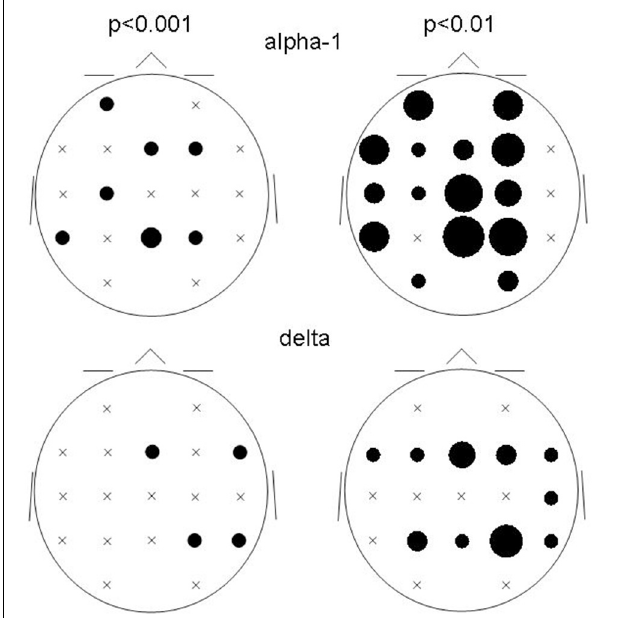
FIGURE 3 | Bubble sizes indicate how many connectivities anchored at each ROI in the comparison between patients and controls. Head seen from above. Semi schematic array of the 19 ROIs; crosses indicate ROIs where no connectivity anchored. Results for the alpha-1 and delta frequency bands are shown for the two non-corrected conjunction p -values of 0.01 and